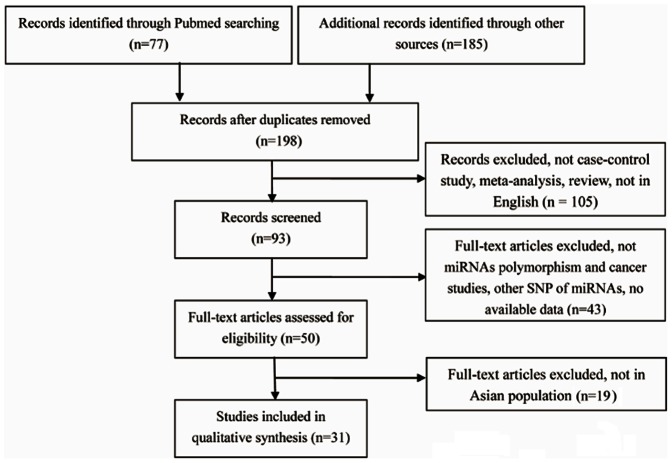
Flow chart of studies identified according to inclusion and exclusion criteria.